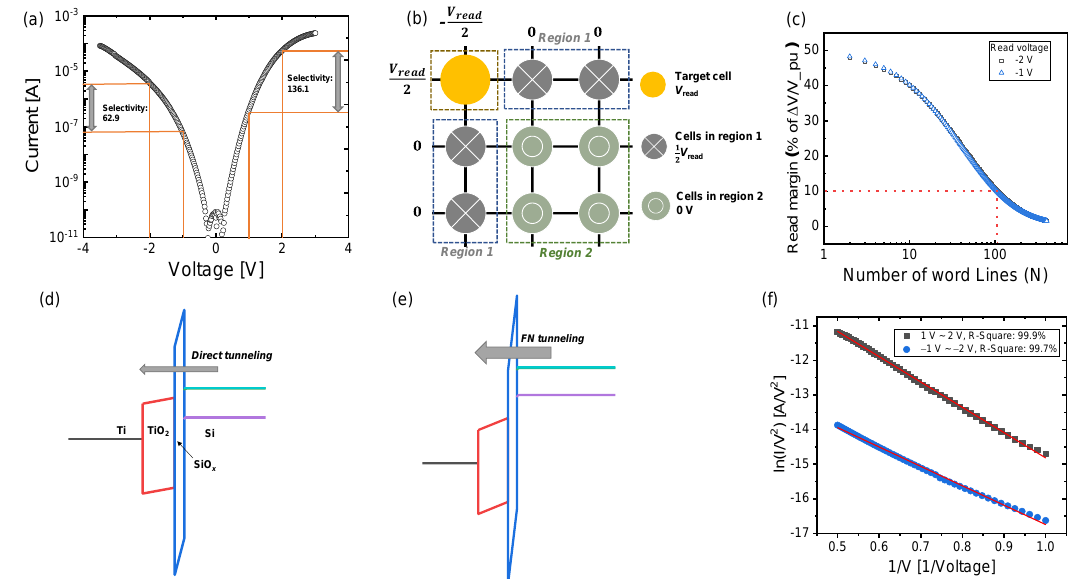
Figure 7. Nonlinear characteristics of TiN/Ti/TiO 2 /SiO x /Si device: ( a ) I–V curve with high selectivity in LRS pulse schemes; ( b ) half-bias scheme in cross-point array structure; ( c ) read margin as a function of number of word lines; energy band diagrams at ( d ) low voltage and ( e ) high voltage; ( f ) ln(I/V 2 ) versus 1/V plot for Fowler–Nordheim (FN) tunnel fitting.